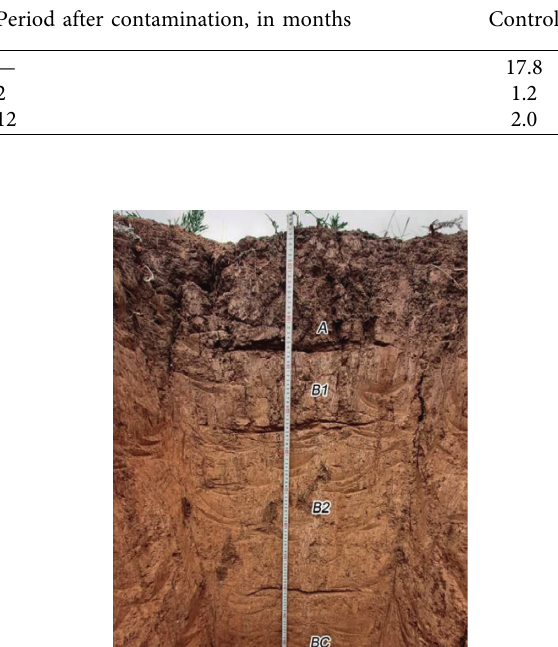
Period after contamination, in months